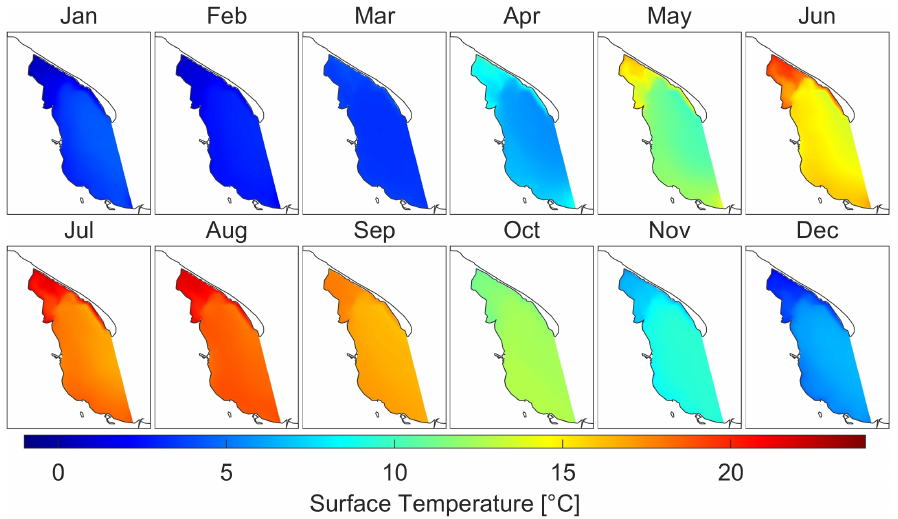
Figure 8. Monthly means of water temperature at sea surface